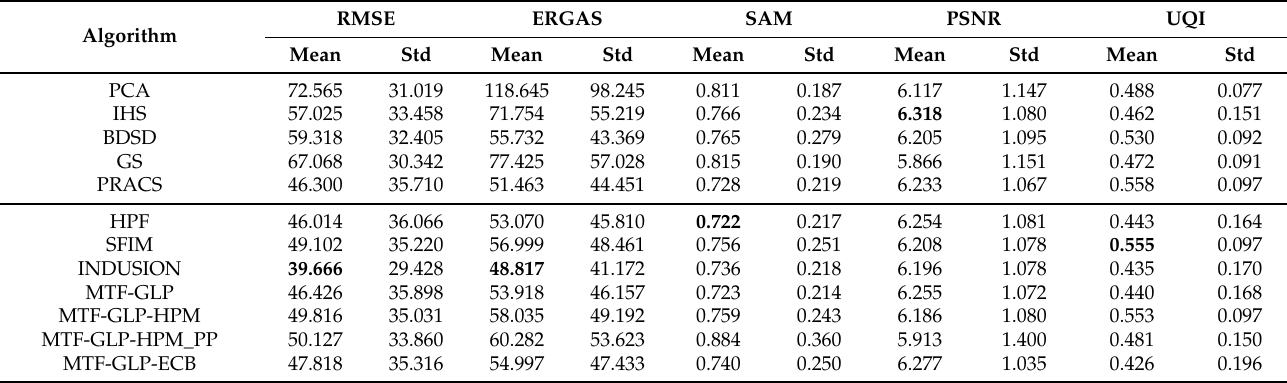
Table 1. Quality indices for the False Colour Thermal Pansharpened images of the FLIR ADAS dataset for each pansharpen- ing algorithm